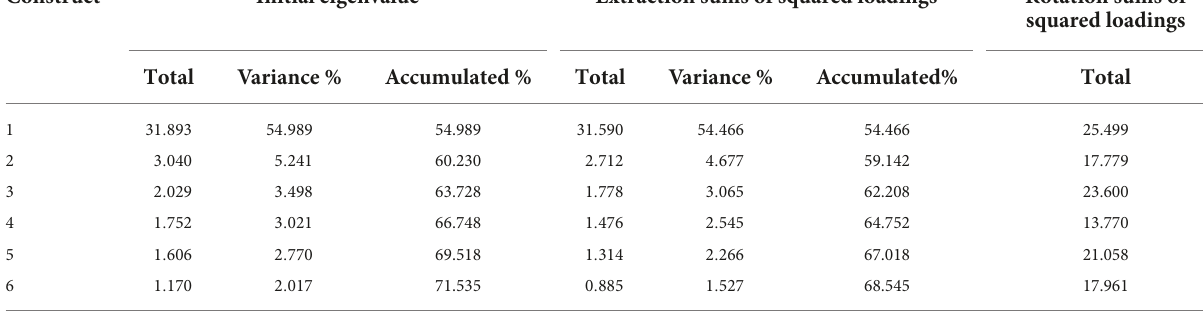
TABLE 2 Total explained variance of the third exploratory factor analysis